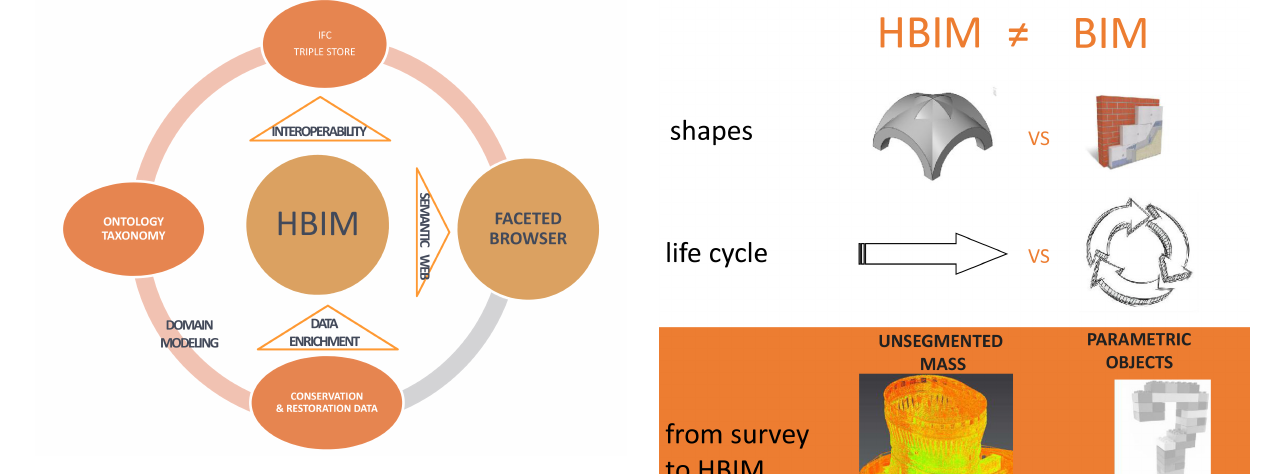
Figure 1. The comprehensive workflow for management of restoration and conservation data, allowing the interoperability between HBIM and faceted browser BIMExplorer thank to do- main ontologies. Figure 2. The image depicts the main differences between a BIM for the construction and the HBIM for the built